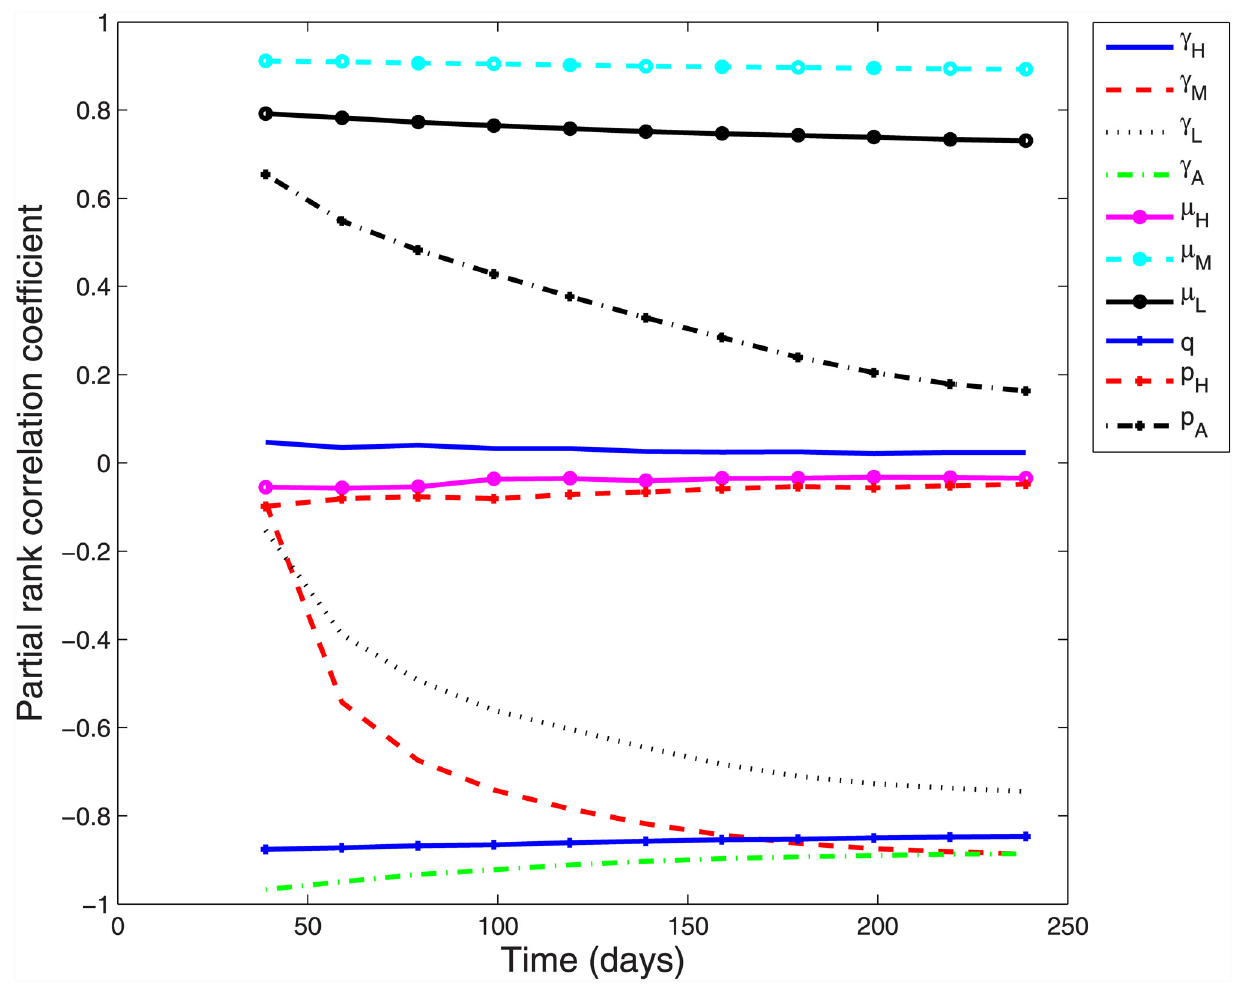
Fig 4. Partial rank correlation for infection severity proportion, mixing and recovery rate parameters over